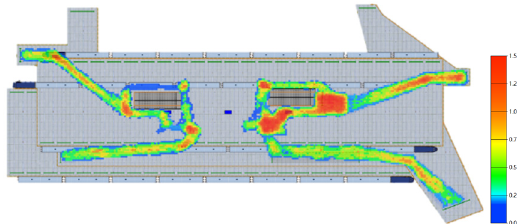
Figure 18. Evacuation of 70% elderly and